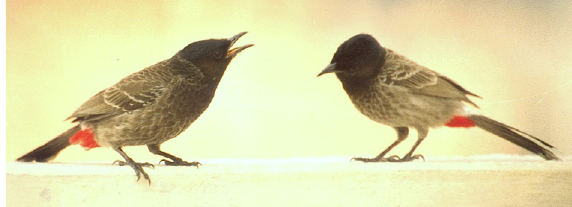
Image 3. A pair of Red-vented Bulbuls performing Greeting Display.